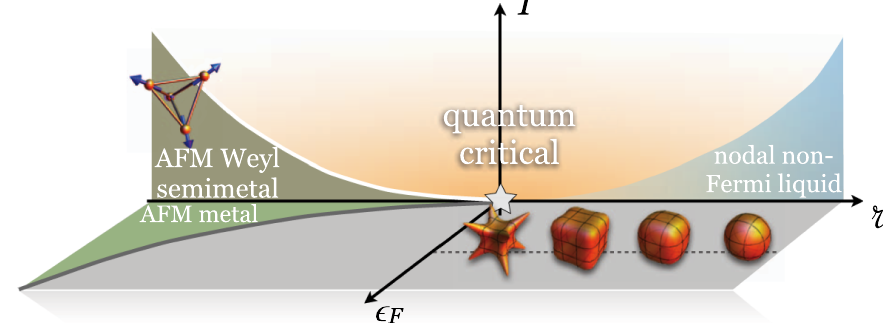
FIG. 1. Quantum critical point (QCP) and quantum criticality driven by the onset of “ all-in-all-out ” (AIAO) magnetism. For r ≥ r (in c this figure the star indicates r ), the nodal non-Fermi liquid (or “ Luttinger-Abrikosov-Beneslavskii ” [10]) phase occurs at T ¼ 0 , with a c quadratic Fermi node, while antiferromagnetic (AFM) all-in-all-out ordering occurs for r < r , with the quadratic node replaced by c linear Weyl points — a Weyl semimetal. The quantum critical regime occurs at T > 0 around r ¼ r . Note that the quantum critical-AFM c boundary (thick white line) is a true (continuous Ising) phase transition. The ϵ axis represents the Fermi energy and parametrizes F electron or hole doping. The three-dimensional (orange) surfaces represent the shapes of the corresponding Fermi surfaces at small doping — the increased anisotropy is apparent as one moves towards the QCP. The phase transition denoted by the thick gray line is expected to exhibit critical properties appropriate to a q ¼ 0 order parameter coupled to a Fermi surface, as in the Hertz formulation [3], though subject to the usual uncertainties regarding the theory of that problem [5 –